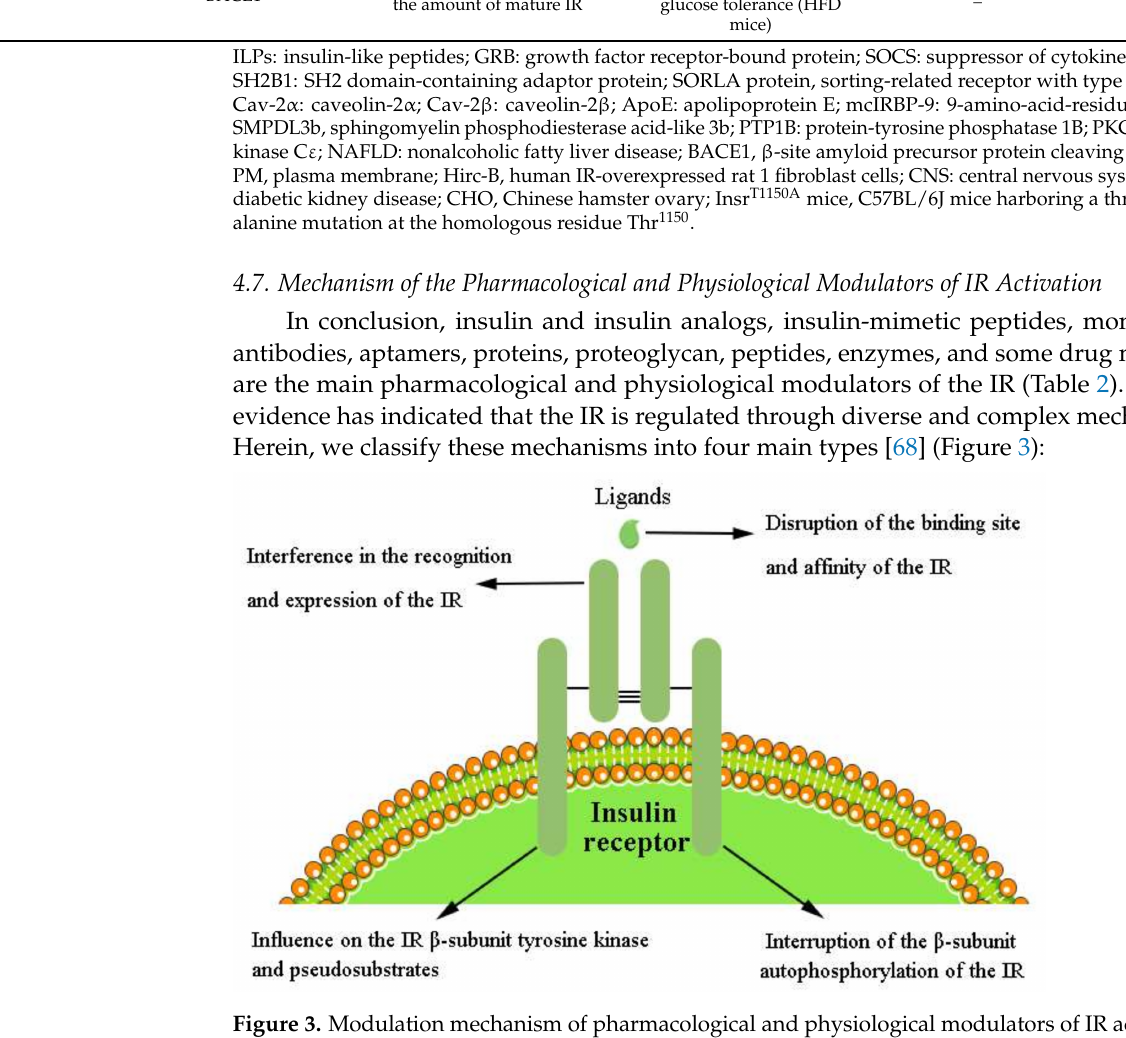
Figure 3. Modulation mechanism of pharmacological and physiological modulators of IR